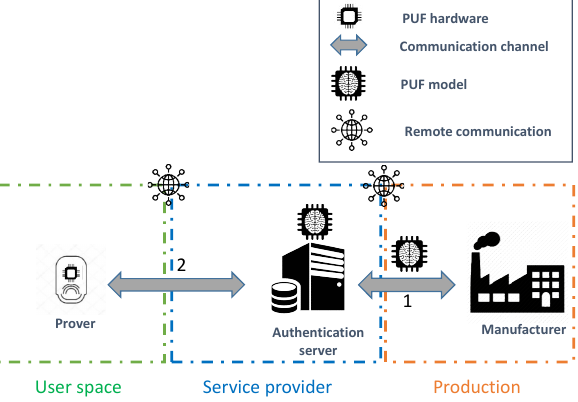
Figure 7. Three-component enrollment procedure.